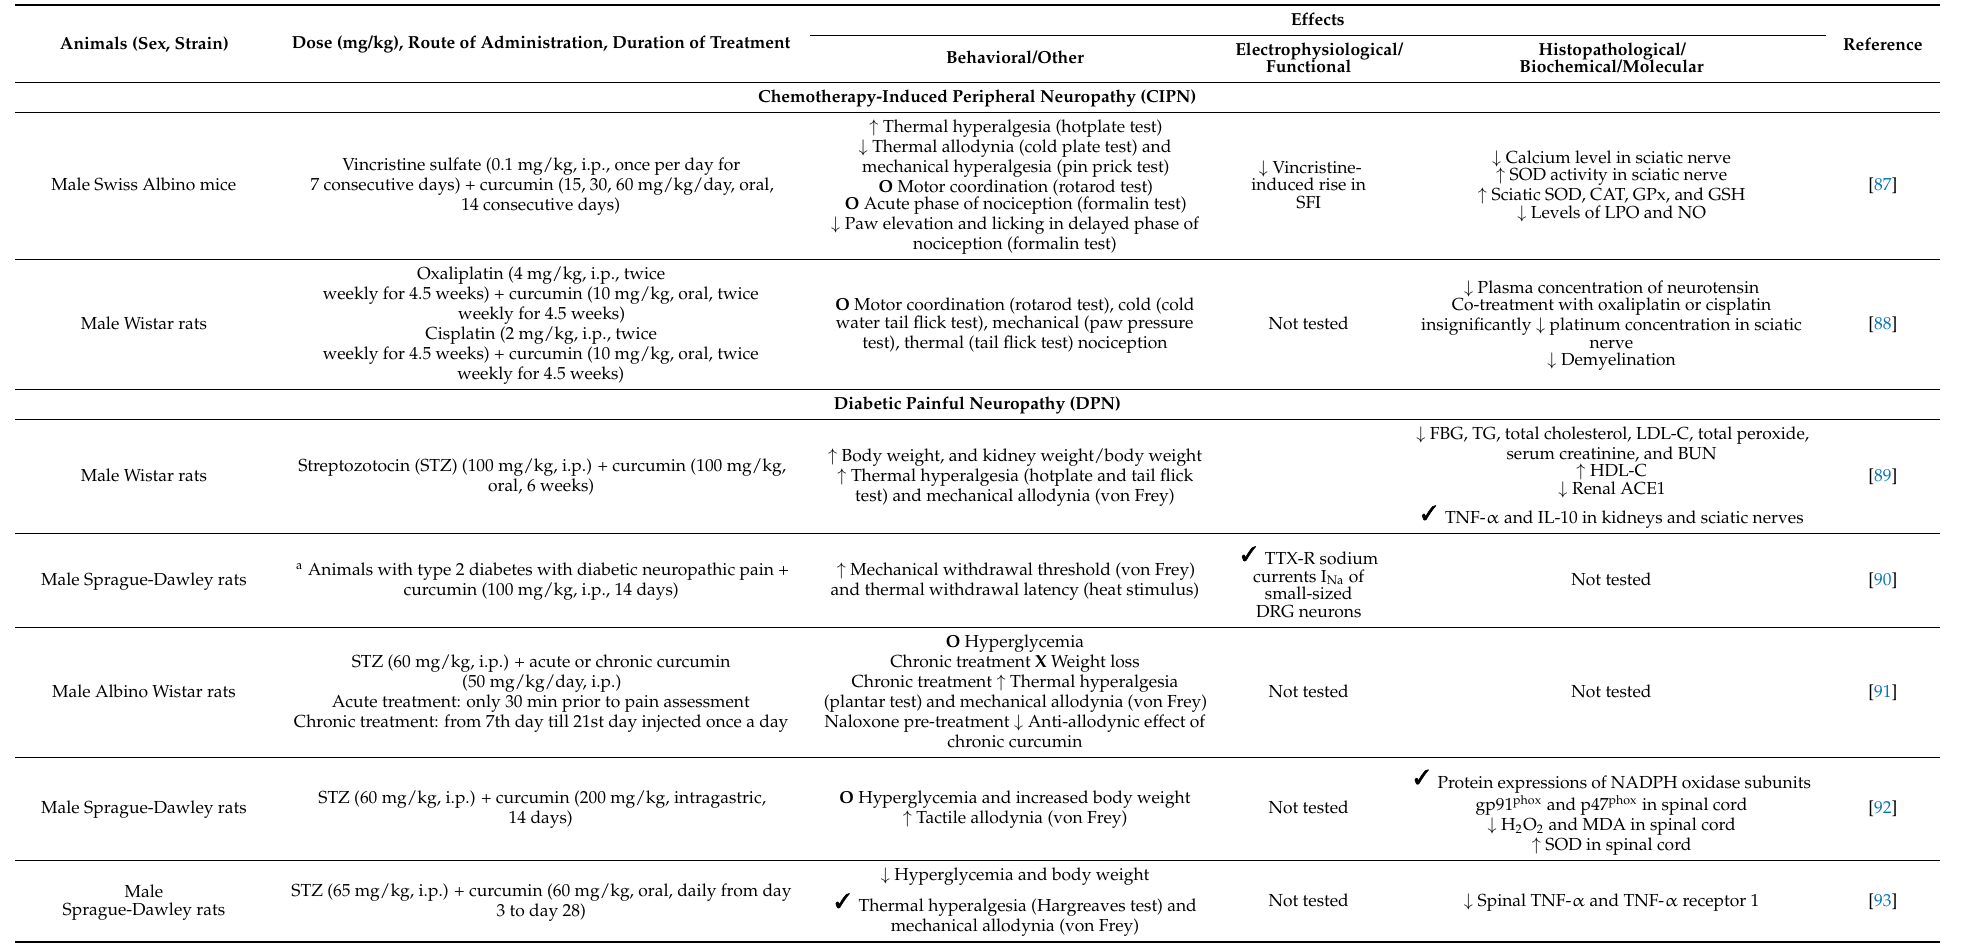
Table 2. Effects of curcumin on alcoholic neuropathy, chemotherapy-induced peripheral neuropathy (CIPN), and diabetic painful neuropathy (DPN).